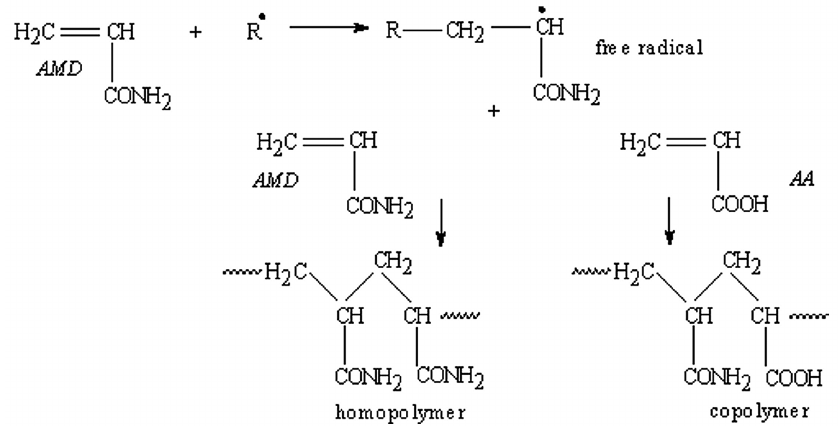
Figure 11. Possible mechanism for obtaining of poly(acrylamide- co -acrylic acid) in presence of “initial radicals” formed from water or initiator.